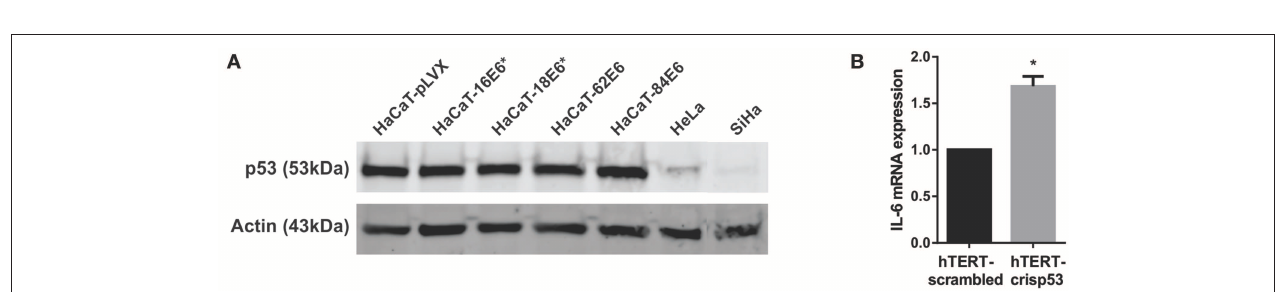
FIGURE 5 | Effect of p53 on IL-6 expression. (A) p53 protein levels evaluated by western blot in HaCaT-pLVX, HaCaT-E6, HeLa, and SiHa cells. Boxes in the upper blot include wells relevant for this experiment, lower edited picture shows the same but in a clearer form. (B) IL-6 expression in hTERT immortalized keratinocytes silenced for p53 (hTERT-crisp53) compared to the control hTERT-scrambled cells. IL-6 expression was measured by qPCR. Actin was used as reference gene. The asterisk indicates statistical significance ( p <